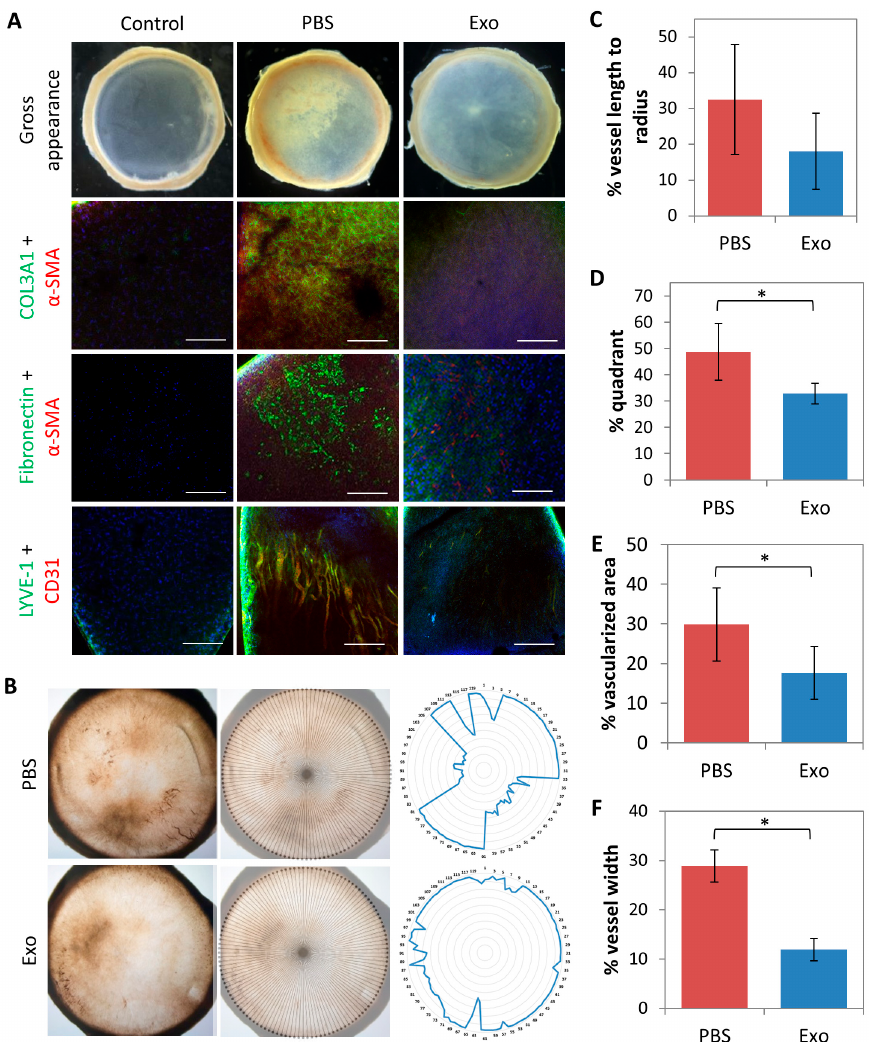
Figure 5. Gross appearance and immunohistochemistry studies of excised cornea. There was a reduction in the corneal haze in the mesenchymal stem cells-derived exosomes (MSC-exo) treated corneas compared to the phosphate-buffered saline (PBS) treated corneas under the stereomicroscope (( A ); top panel). MSc-exo treated corneas had lower expression of fibronectin (green fluorescence), collagen 3A1 (green fluorescence), and α -SMA (red fluorescence) compared to PBS-treated corneas (( A ); second and third row panels). CD31 (red fluorescence) with LYVE-1 (green fluorescence) colocalization staining on the excised corneas revealed a reduction of the vascularized area that received MSC-exo treatment compared to PBS (( A ); bottom panel). DAPI (blue fluorescence) stained the nuclei. Quantification analysis showed that MSC-exo-treated corneas had reduced blood vessel lengths to the corneal radius ( B , C ), percentage quadrant with vessels ( B , D ), and percentage corneal area with vessel ingrowth ( B , E ), compared to PBS-treated corneas. Vessel width was significantly lower in the MSC-exo-treated corneas, compared to controls ( F ). * p < 0.05. Scale bars = 200 µ